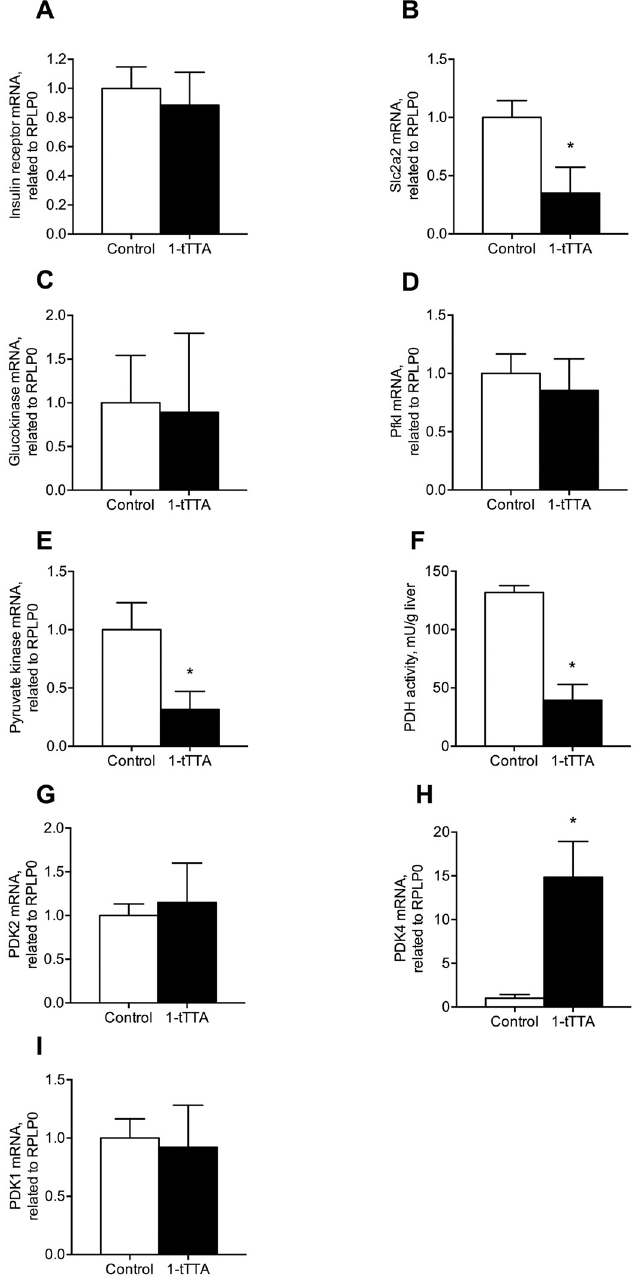
Fig 3. Hepatic mRNA levels and activity of enzymes involved in glycolysis after 3 weeks treatment with vehicle (control) or 1-triple TTA (1-tTTA) in rats. ( a ) Insulin receptor mRNA level, ( b ) Slc2a2 mRNA level, ( c ) glucokinase mRNA level, ( d ) phosphofructokinase ( Pfkl ) mRNA level, ( e ) pyruvate kinase mRNA level, ( f ) pyruvate dehydrogenase (PDH) complex activity, ( g ) pyruvate dehydrogenase kinase, isoenzyme 2 ( Pdk2 ) mRNA level, ( h ) pyruvate dehydrogenase kinase, isoenzyme 4 ( Pdk4 ) mRNA level, ( i ) pyruvate dehydrogenase kinase, isoenzyme 1 ( Pdk1 ) mRNA level. Gene expression levels were normalized to the house keeping gene Rplp0 and relative values are given. All values shown are means with standard deviation (n = 6–8). Statistically significant differences between means were determined using Students t-test, � p < 0.05 vs. control.